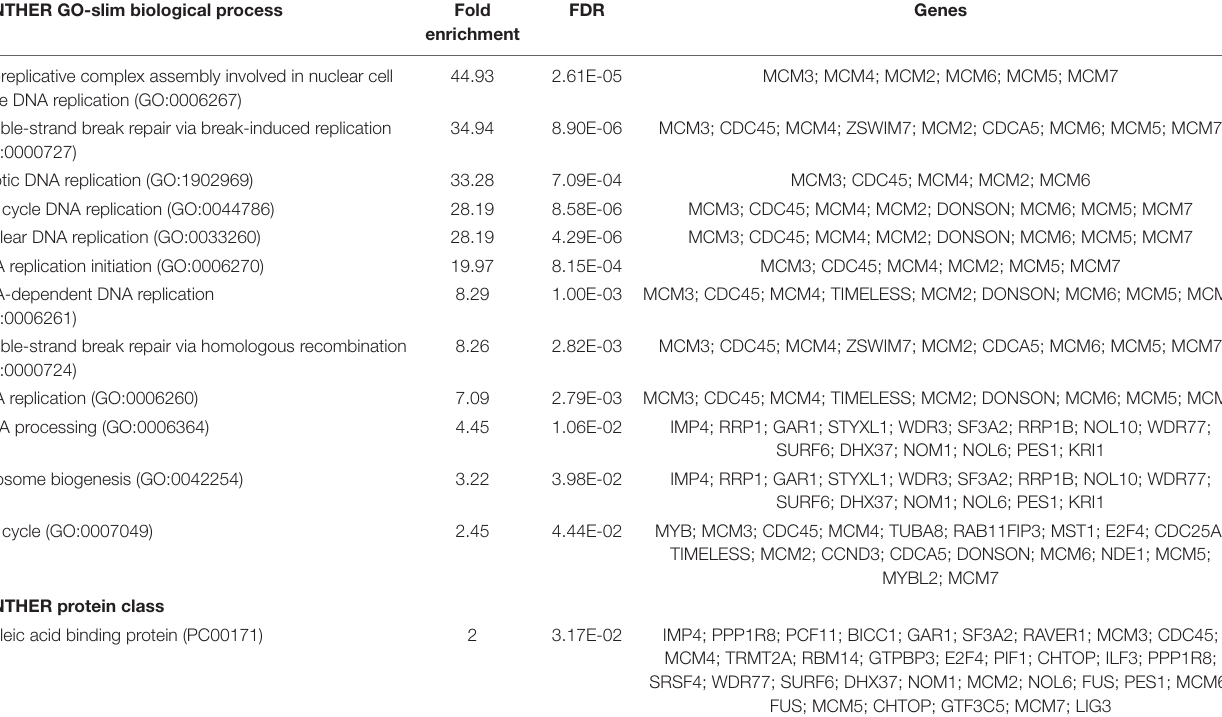
TABLE 7 | Enrichment of genes overexpressed in ICM under “SF” versus “SC” IVP conditions. PANTHER GO-slim biological process Fold